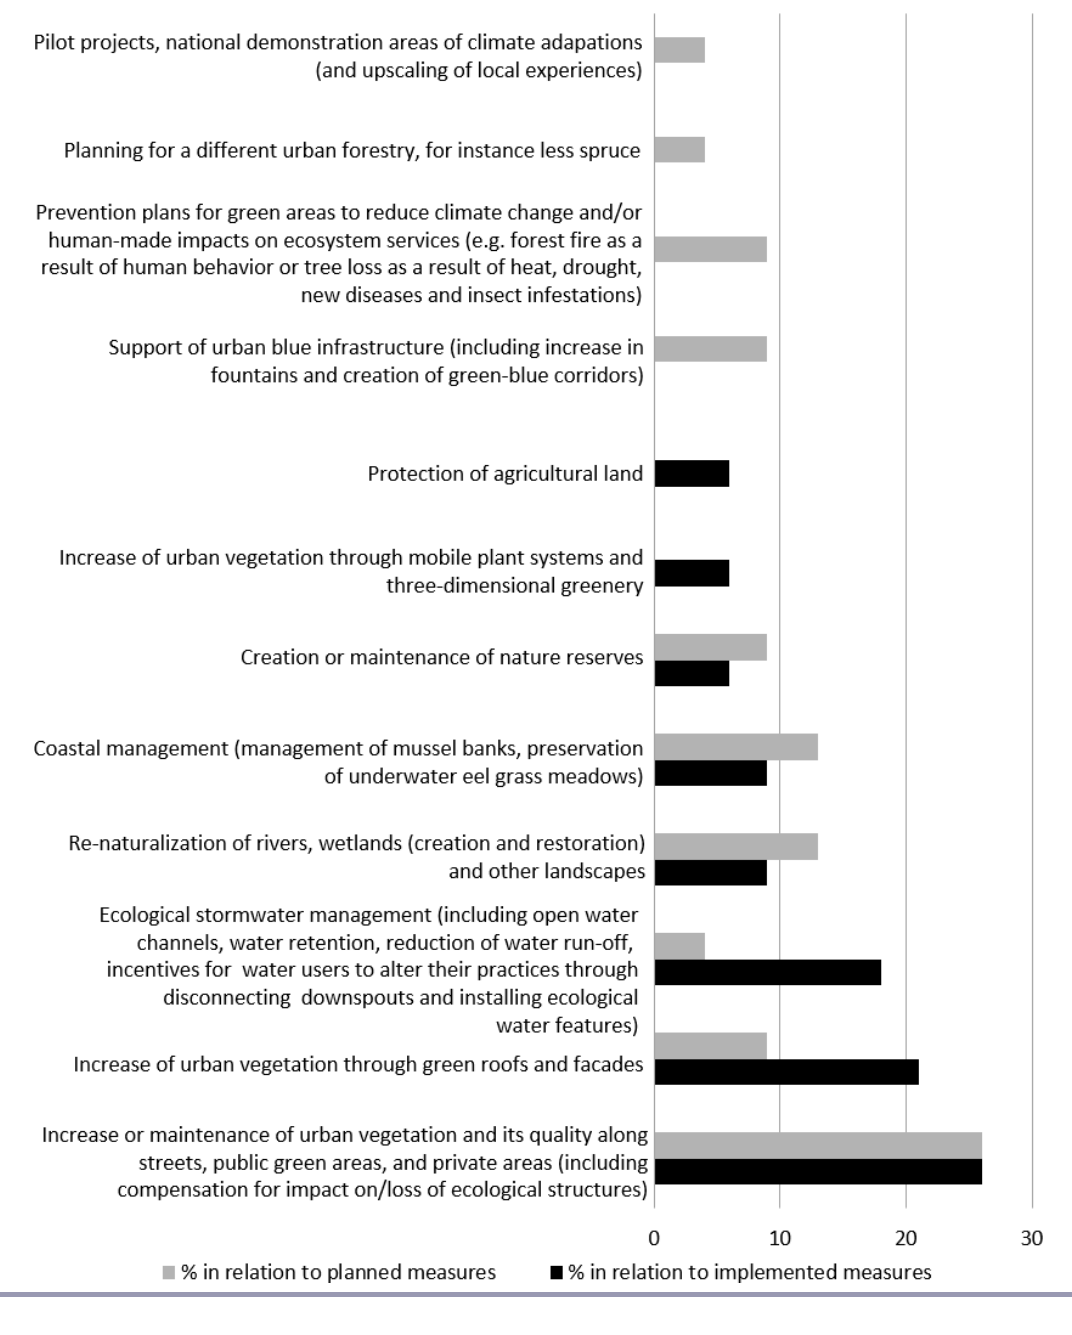
Fig. 3 . Types of ecosystem-based adaptation measures